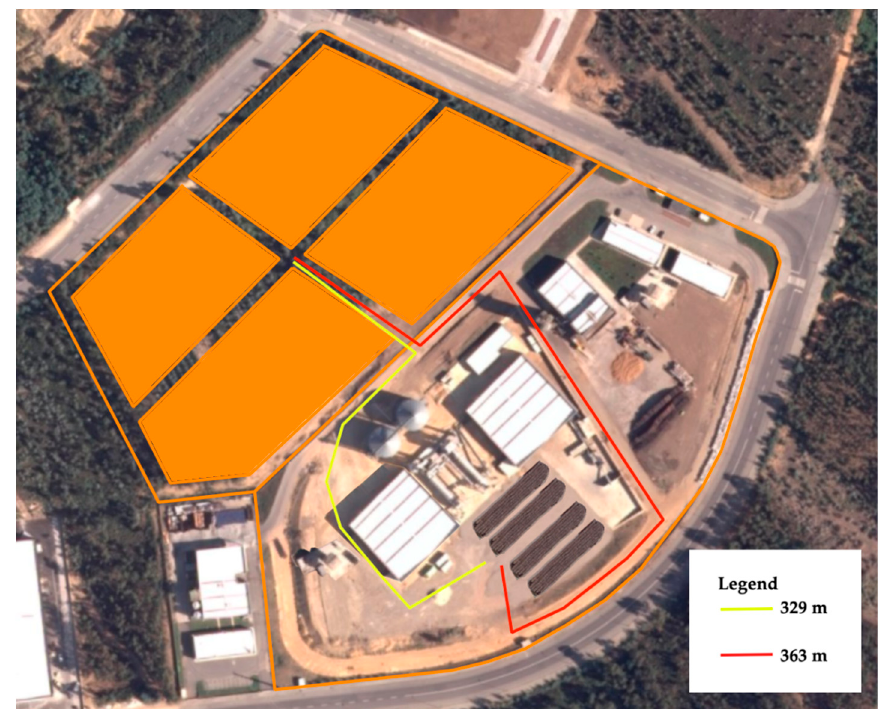
Figure 3. Representation of two possible routes for transport between parks, indicated by yellow and red lines.